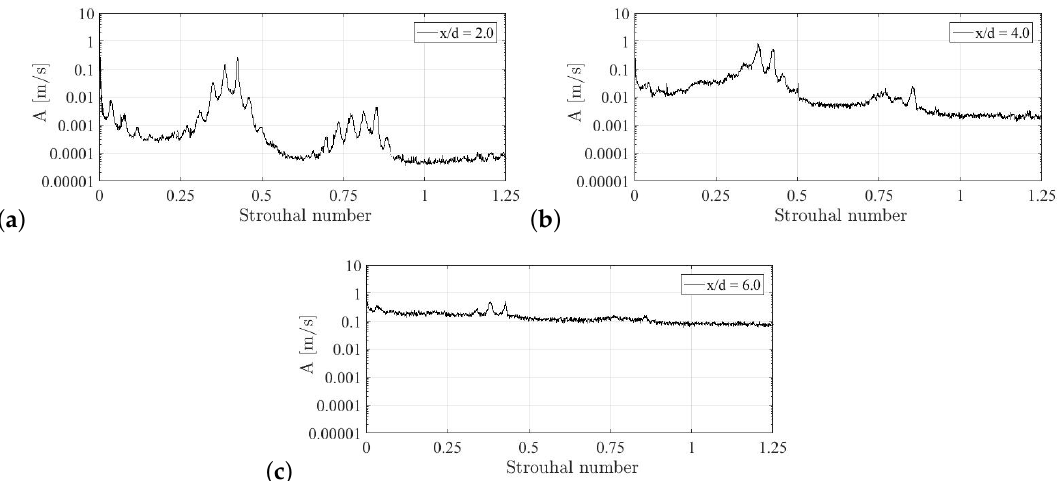
Figure 13. Evolution of spectra of axial velocity fluctuations, S = 0.5, L / D = 25, Re = 10,000: